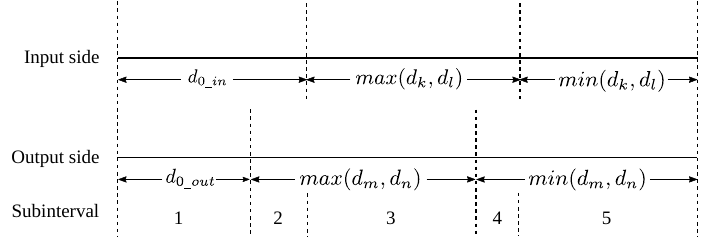
Figure 18. Switching sequence for single capacitor